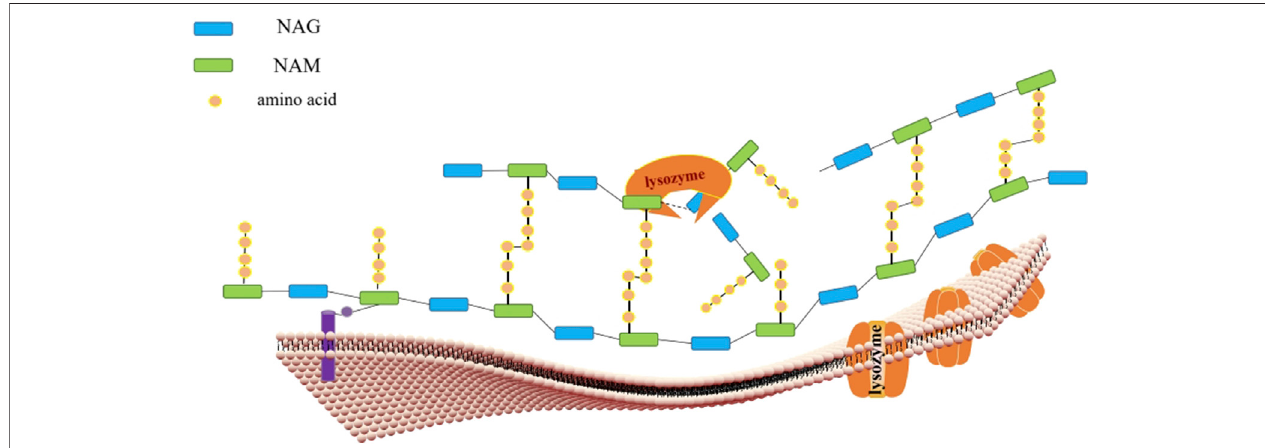
FIGURE 2 | Lysozyme is antibacterial through these two mechanisms. The peptidoglycan(PG) skeleton of bacterial cell wall is connected by NAG and NAM through peptide stem, and then anchored on the cell membrane (purple) through lipid carrier. Lysozyme (golden yellow) hydrolyzes the interaction between NAG and NAMonPG β -1,4glycosidicbonds,leadingtobacterialcellwallinstabilityandbacterialdeath.Secondly,lysozyme(goldenyellow)canformporesonnegativelycharged cell membrane by using its own cation mechanism to achieve